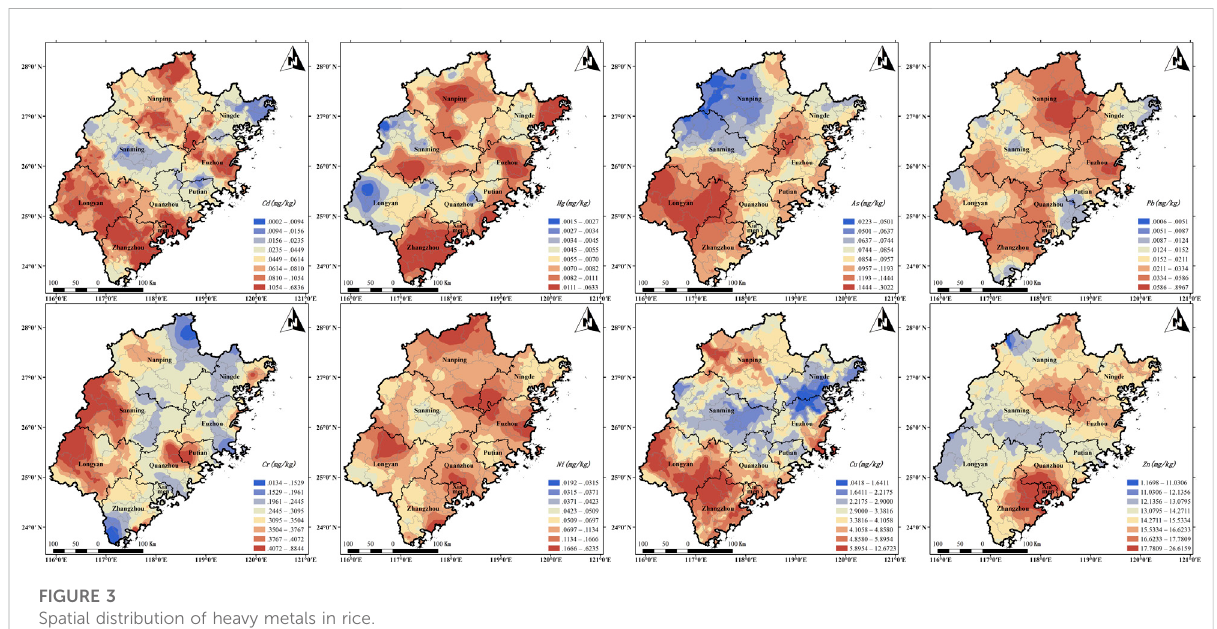
FIGURE 3 Spatial distribution of heavy metals in rice.